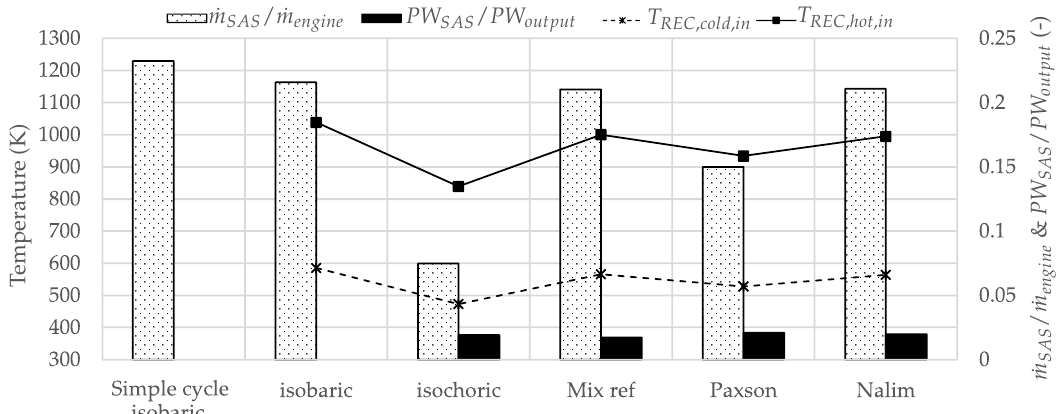
Figure 13. Recuperator inlet temperatures and SAS mass flow and SAS compressor power for the recuperated cycle.